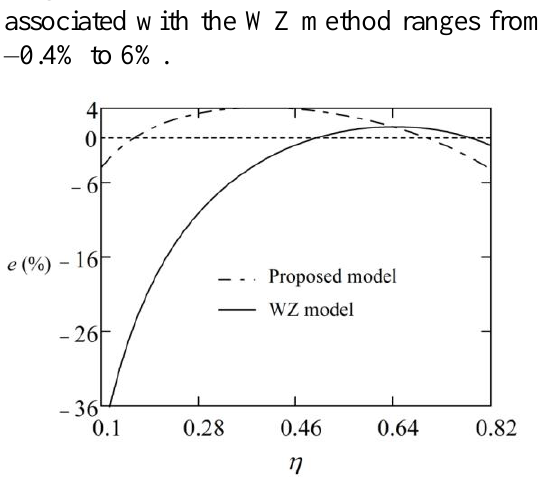
Fig. 3. Comparison of the errors in the estimated discharge of proposed and existing kinematic parameters for constant n value.